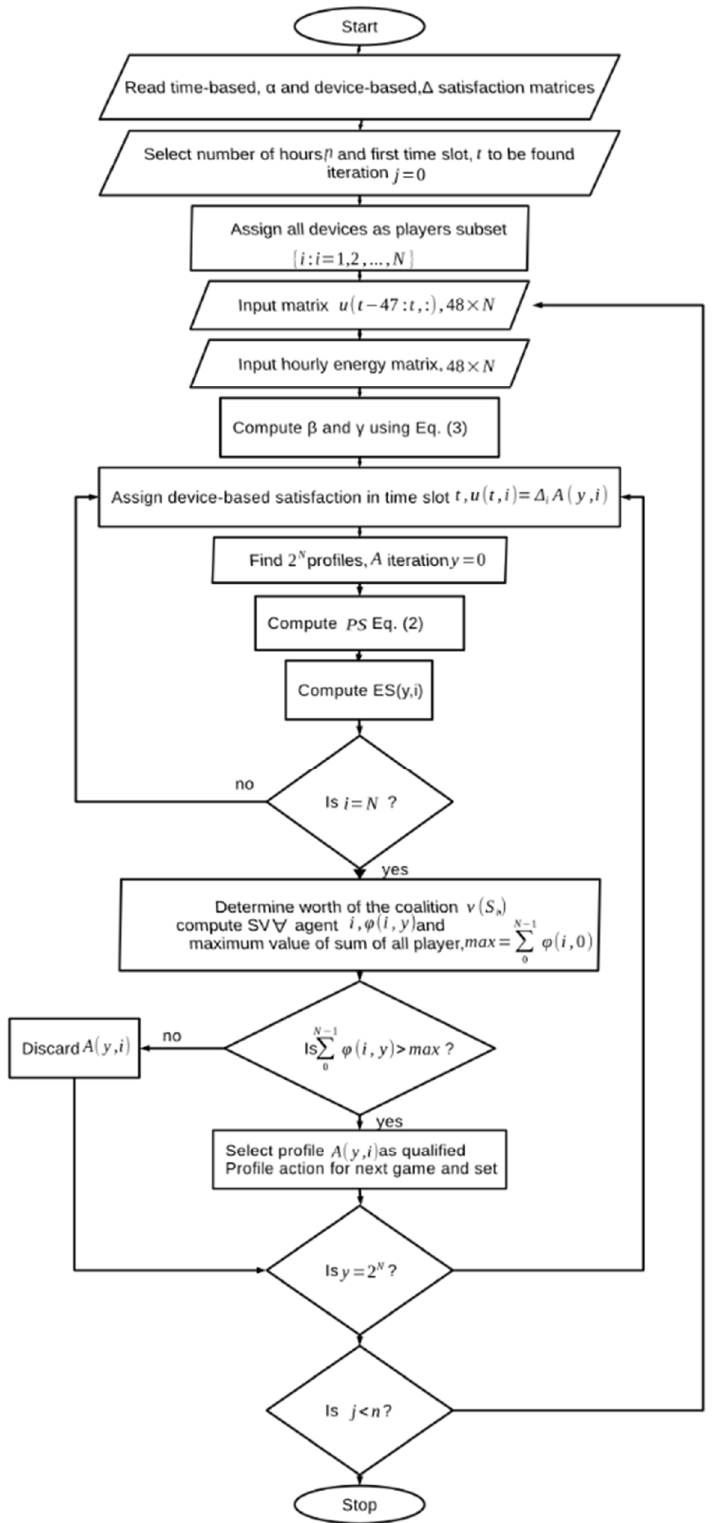
Figure 1. Flowchart for cooperative game implementation.